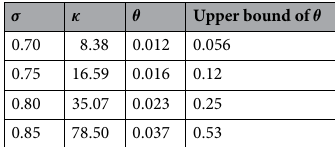
Table 3. Normalized errors of Richardson-Lucy deconvolution